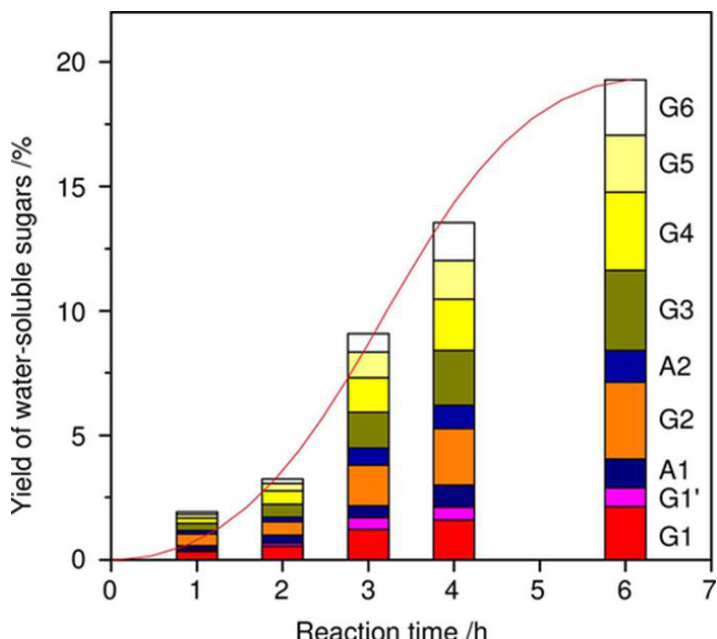
Figure 6. Dependence of yield of water-soluble sugars on reaction time (milling time). Reaction